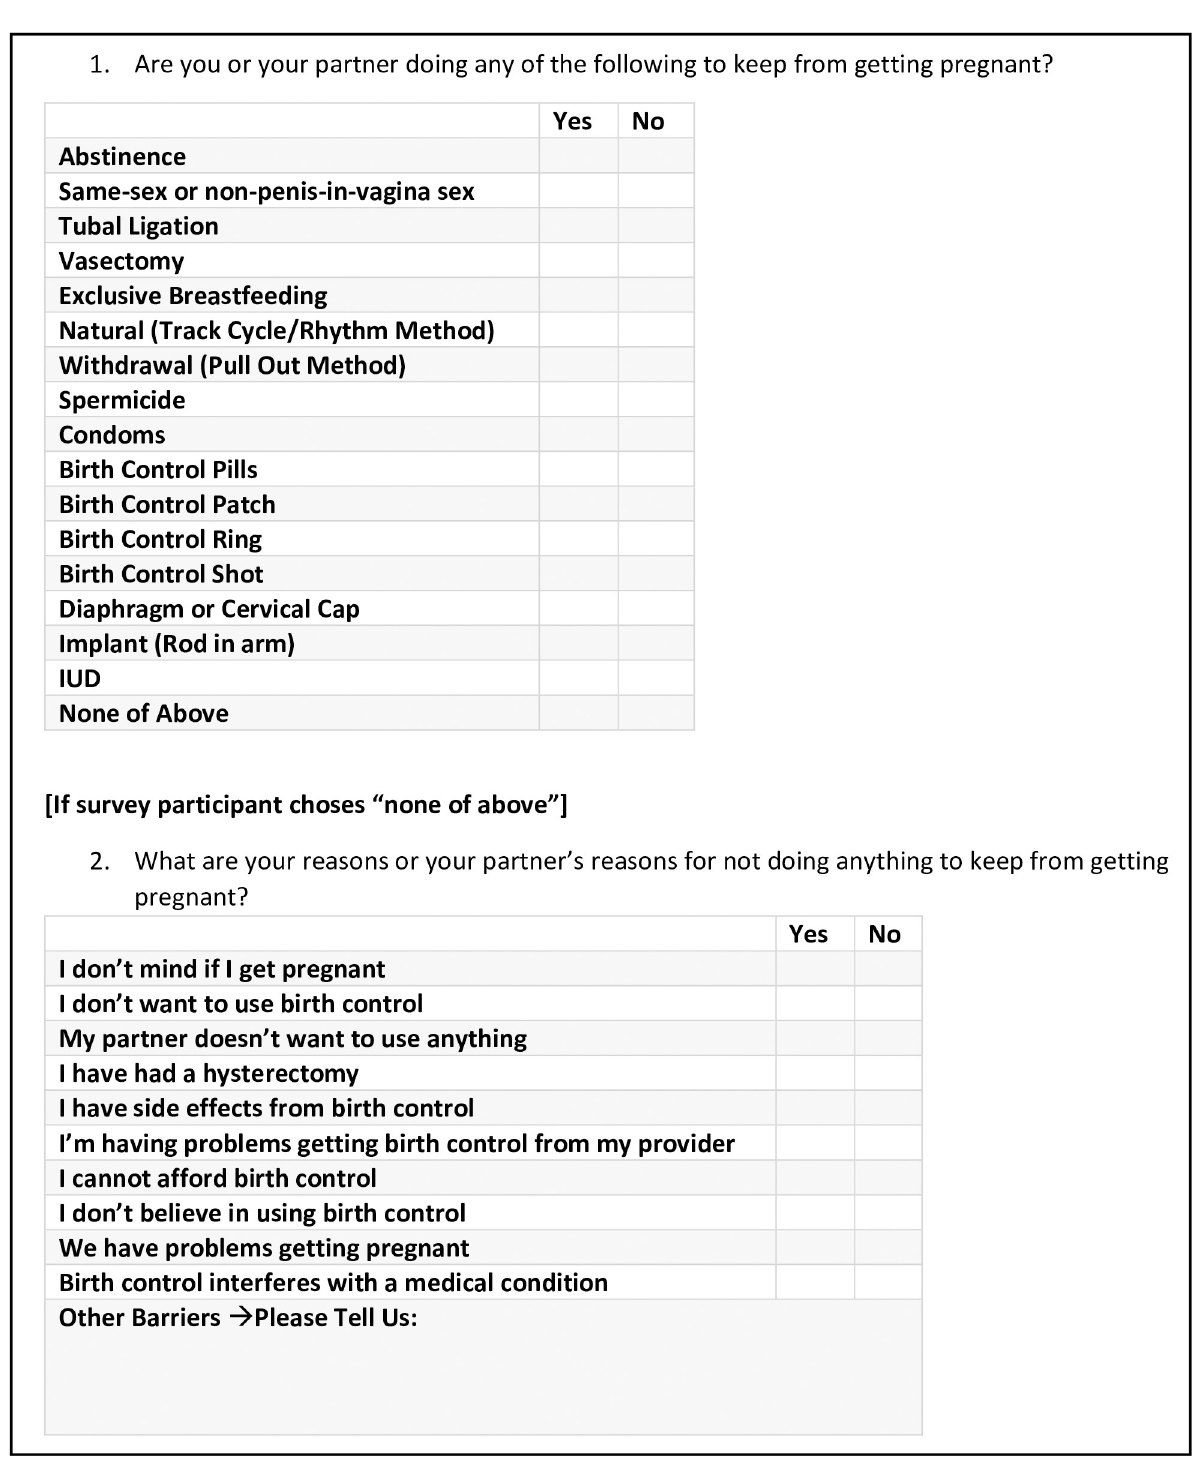
Fig 2. Example of comprehensive contraception behavior survey questions. Revising current contraception behavior survey questions to a checklist approach may better engage the participant to elicit more accurate and detailed information. IUD, intrauterine device.